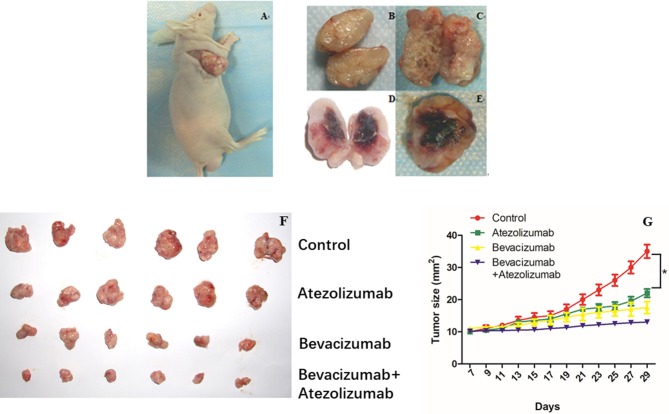
Simultaneous Bevacizmab combining Atezolizumab therapeutic strategy induced synergistic anti-tumor effect in vivo. (A) Female BALB/C nude mice were inoculated subcutaneously with A2780cis cells and were given with IgG as control, Bevacizumab (5 mg/kg) every 48 h, Atezolizumab (10 mg/kg) every 48 h, Bevacizumab (5 mg/kg) + Atezolizumab (10 mg/kg) every 48 h. (B–E) Tumors were cut open longitudinally after they were taken out from killed mice. (F) Isolated tumors from four different groups were showed neatly. (G) Data are presented as mean ± standard deviation of 6 mice of each group. *P < 0.05.